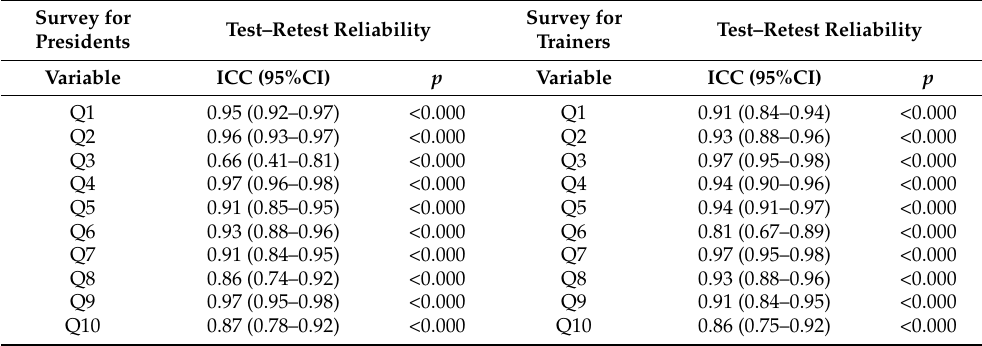
Table 3. Test re-test reliability.